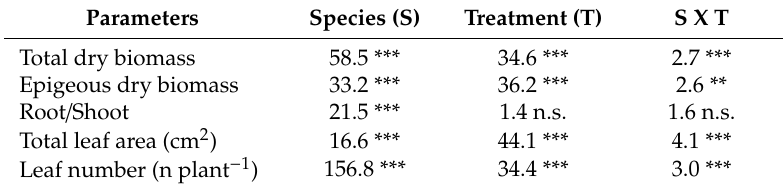
Table 2. F-values related to the main factors and their interaction between the observed and calculated variables, with significance determined from